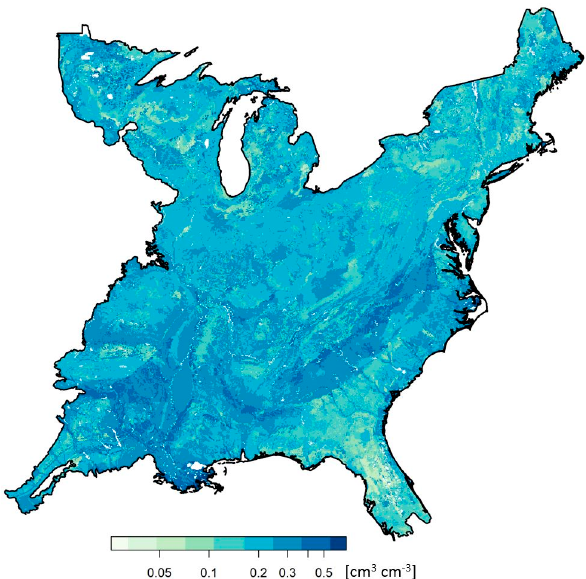
Figure 8. Average of all RZSM produced by the regional SMAR model with data from all three satellite platforms (AMSRE, SMOS, SMAP). The relative RZSM is transformed to volumetric root-zone soil moisture content (cm 3 cm -3 ) with CONUS root-zone porosity data (porosity data not shown here).